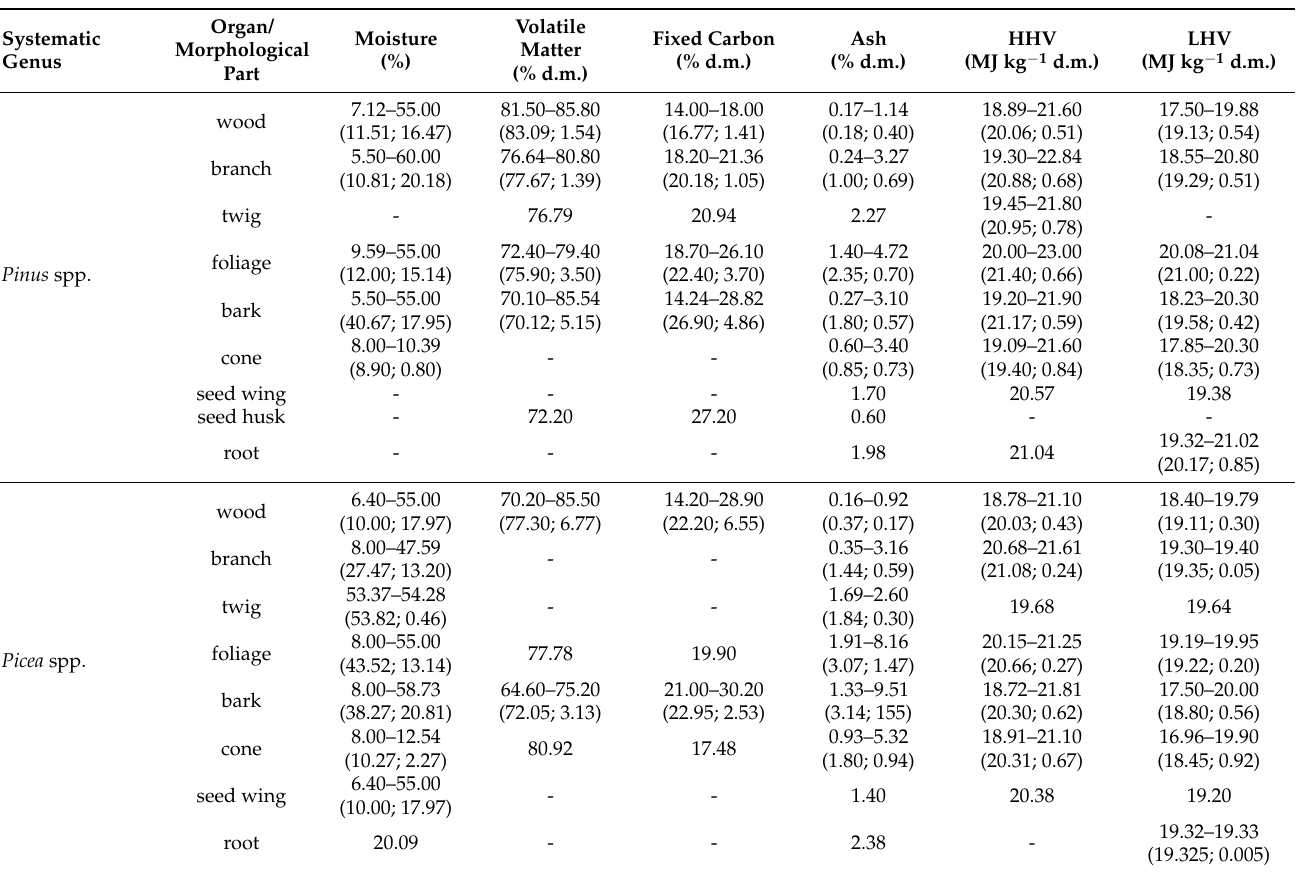
Figure A4. Average value and average deviation of the contents of other extracts in the organs of particular systematic genera trees. Table A1. Thermophysical properties and proximate analyses of particular organs of various sys- tematic genera of trees.